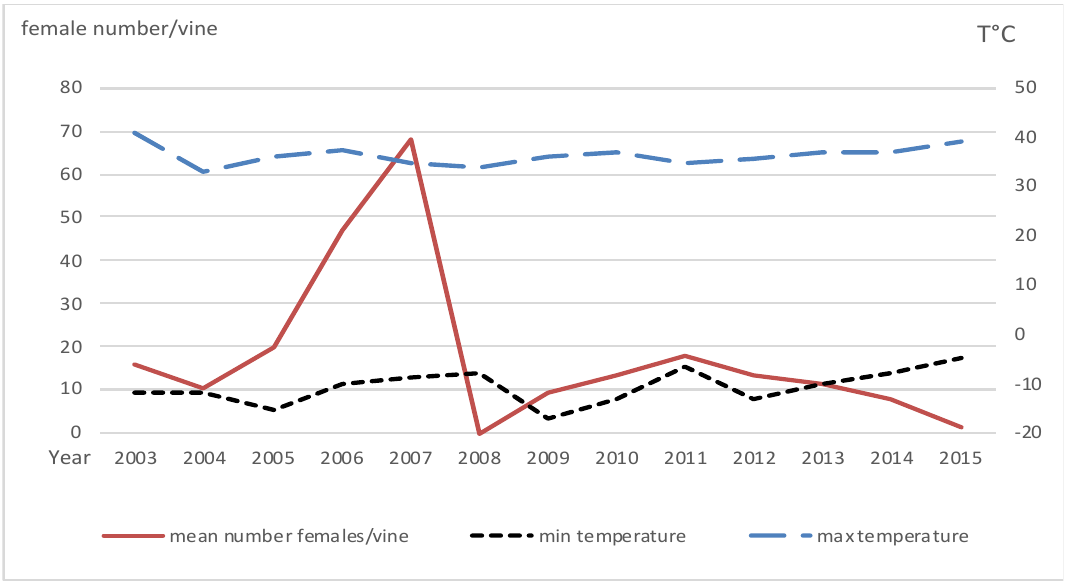
Table 1. Dates of first temperature ≤ 5 °C in October during the survey of Parthenolecanium corni female populations.